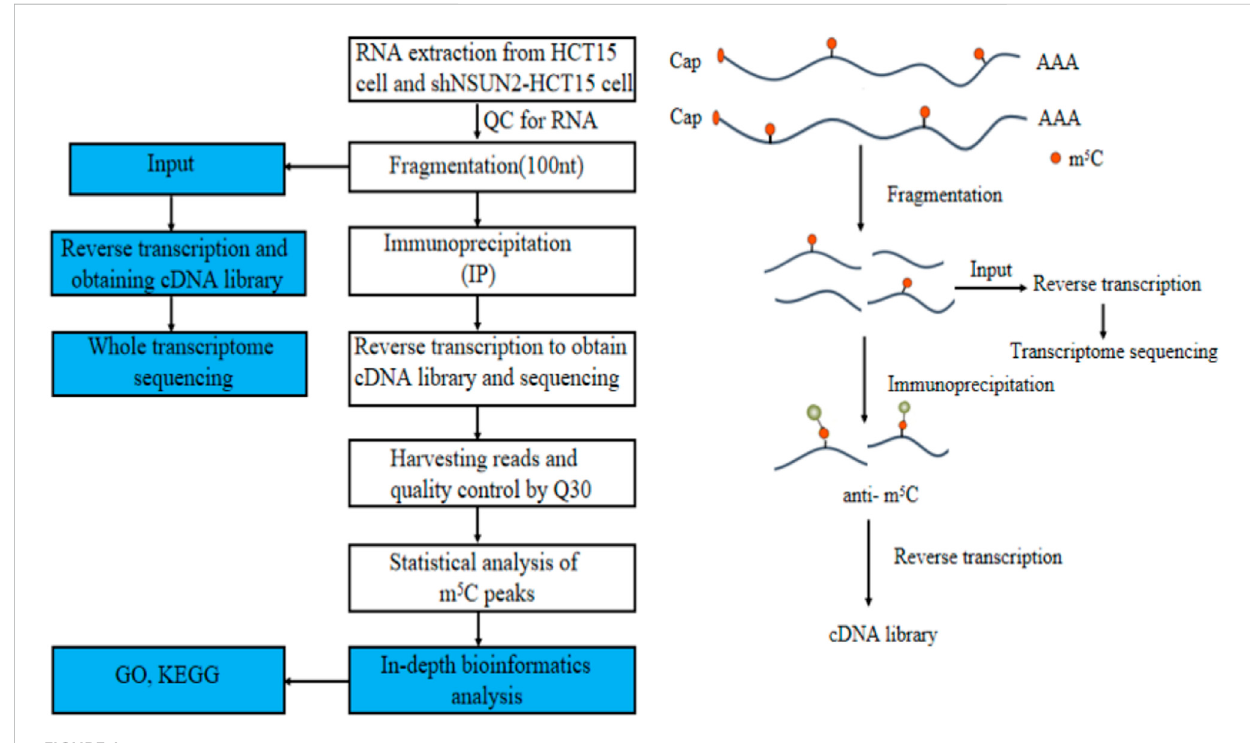
FIGURE 1 Flowchart of the